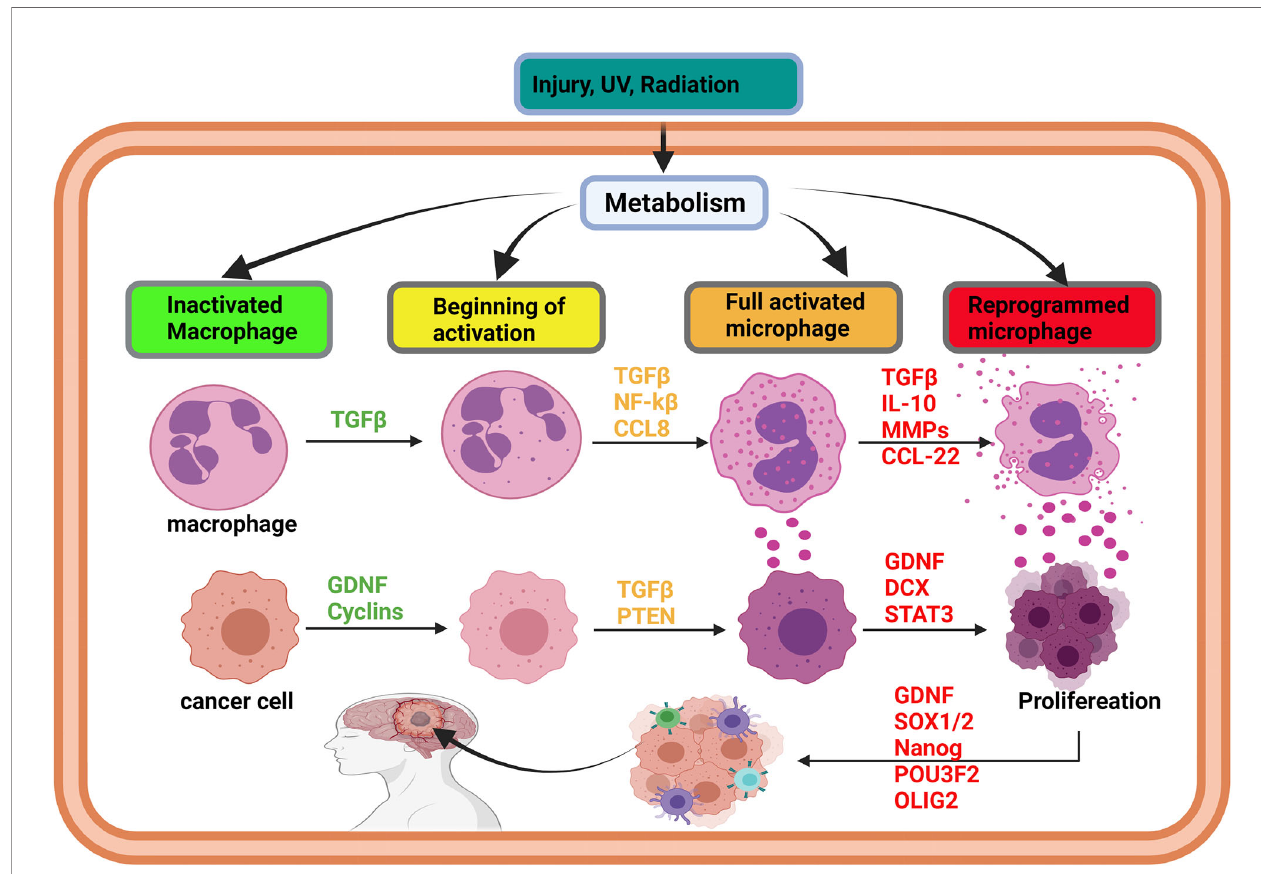
FIGURE 2 | Initiation of glioma via immune cell reprogramming of cancer-associated macrophages. In brain injury, the activation of metabolism can affect the cells ’ DNA and promote gene methylation and acetylation. The effects of metabolism on oncogene lead to methylation, acetylation, resulting in their overexpression. Simultaneously, overexpression of oncogenes, such as TGF-beta and IL-10, promotes macrophages ’ activation and reprogramming, leading to the overexpression of cytokines by an immune cell. As long as the injury persists, TGF-beta family members and cytokine will be overexpressed to heal the injury. The synergistic effect of TGF-beta and cytokines can induce the transformation of the surrounding cell into a cancer cell and trigger proliferation. Cancer initiating cells can also be reprogrammed into stem-like tumor-propagating cells, spread in the brain, and cause glioma. Glioma initiation is mediated by intrinsic (metabolism, epigenetic modi fi cation) and extrinsic factors like U.V. and